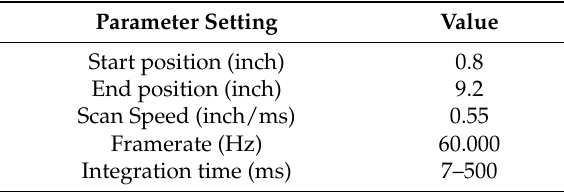
Table 1. The setting of the system in Middleton